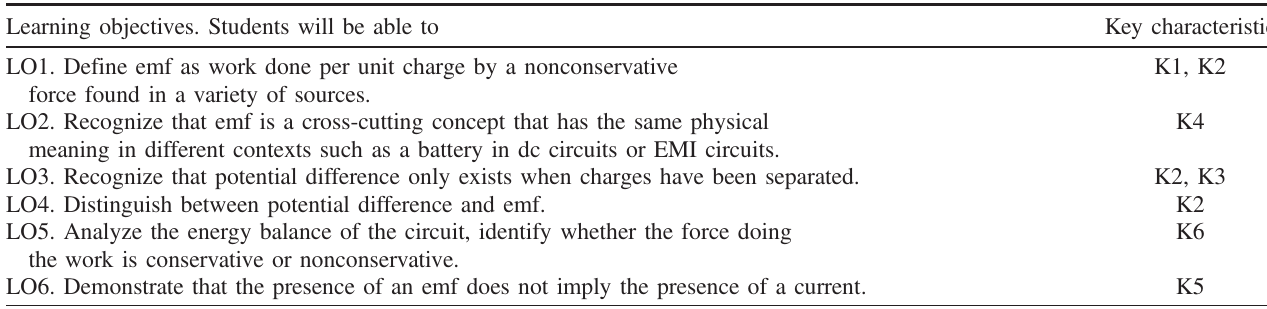
TABLE II. The relation between learning objectives and key characteristics is presented. Learning objectives. Students will be able